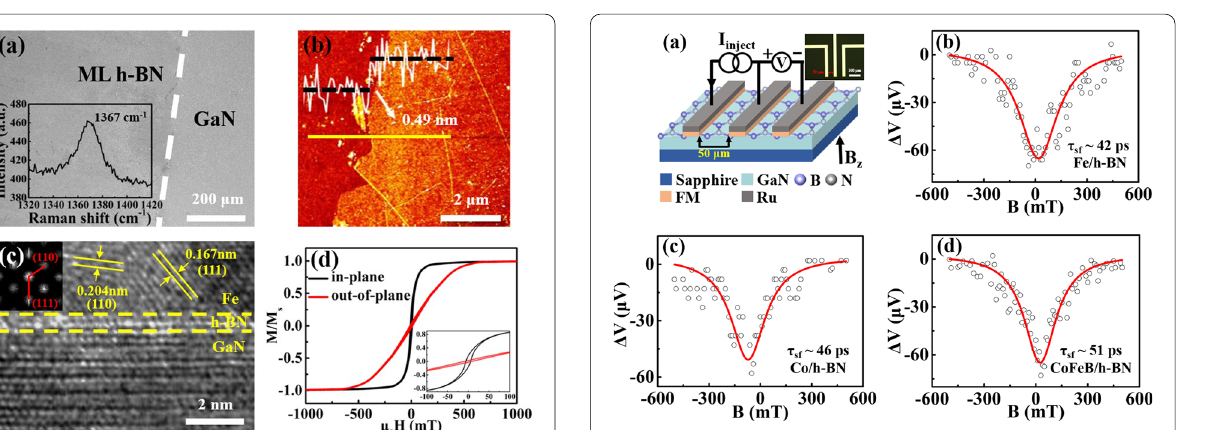
Fig. 2 ( a ) Schematic and optical image (inset) of the three-terminal spin valve devices; ( b , c , d ) Hanle curves of the Fe/h-BN/GaN, Co/h-BN/GaN, and CoFeB/h-BN/GaN three-terminal spin valve devices at RT,